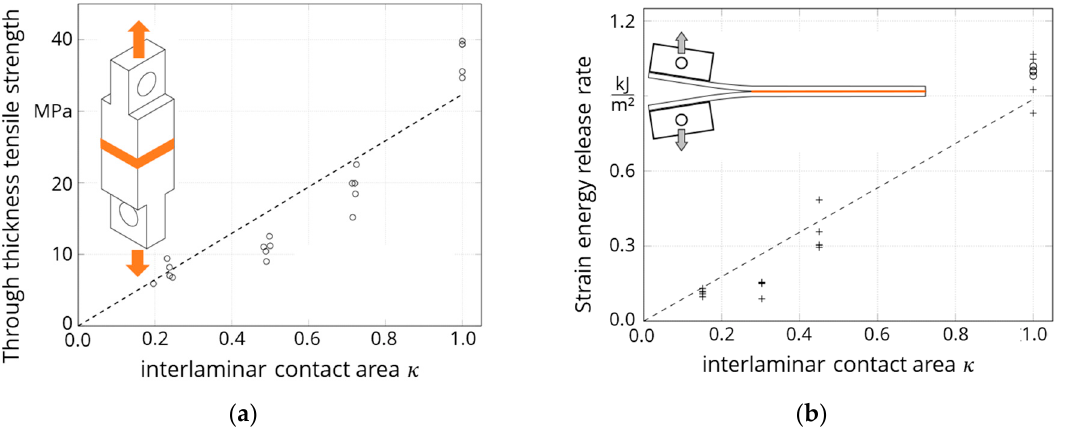
Figure 4. ( a ) Through-thickness tensile test results and ( b ) DCB test results for different interlaminar contact areas.